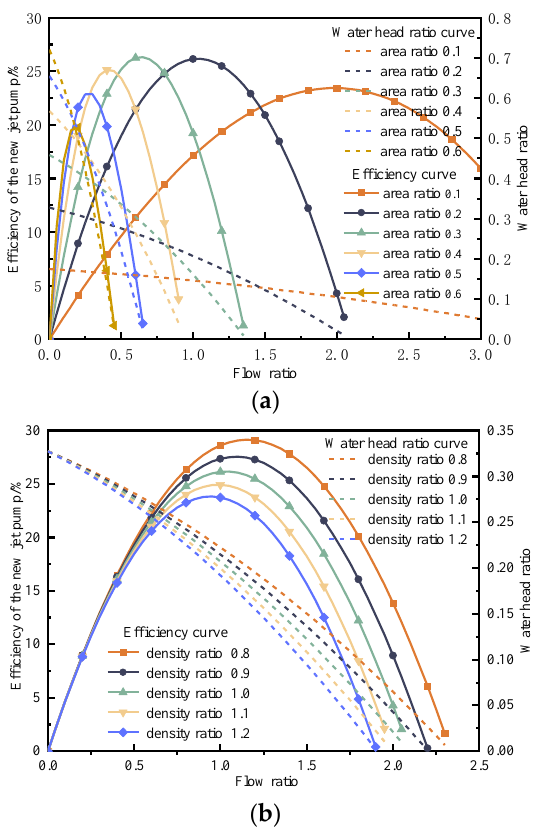
Figure 4. Performance envelope curve of the new jet pump. ( a ) Performance envelope curves of the new jet pump with different area ratios. ( b ) Performance envelope curves of the new jet pump at different density